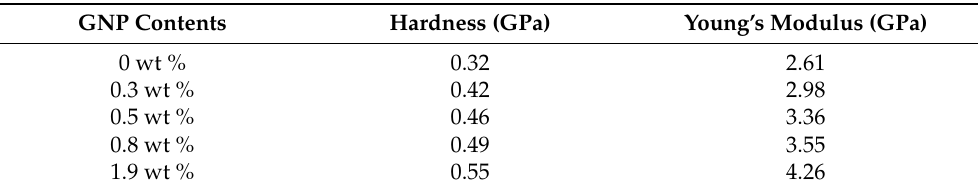
Figure 8. SEM images of surface morphologies ( a ) neat epoxy, ( b ) nanocomposite reinforced with 0.3 wt % GNP, ( c ) nanocomposite reinforced with 0.8 wt % GNP. Table 1. Hardness and Young’s modulus of nanocomposite films incorporated with various contents of GNPs evaluated at the indentation depth of 320